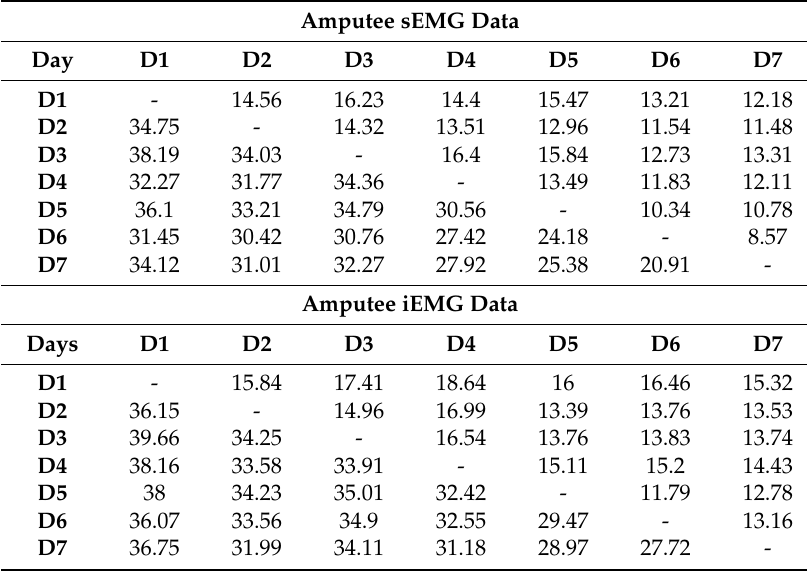
Table 2. SSAE vs. LDA performance and sEMG vs. iEMG data comparison for transradial amputee subjects. In each matrix, the upper diagonal triangle represents the mean classification errors obtained with SSAE and the lower diagonal triangle represents errors obtained with LDA for corresponding pair of